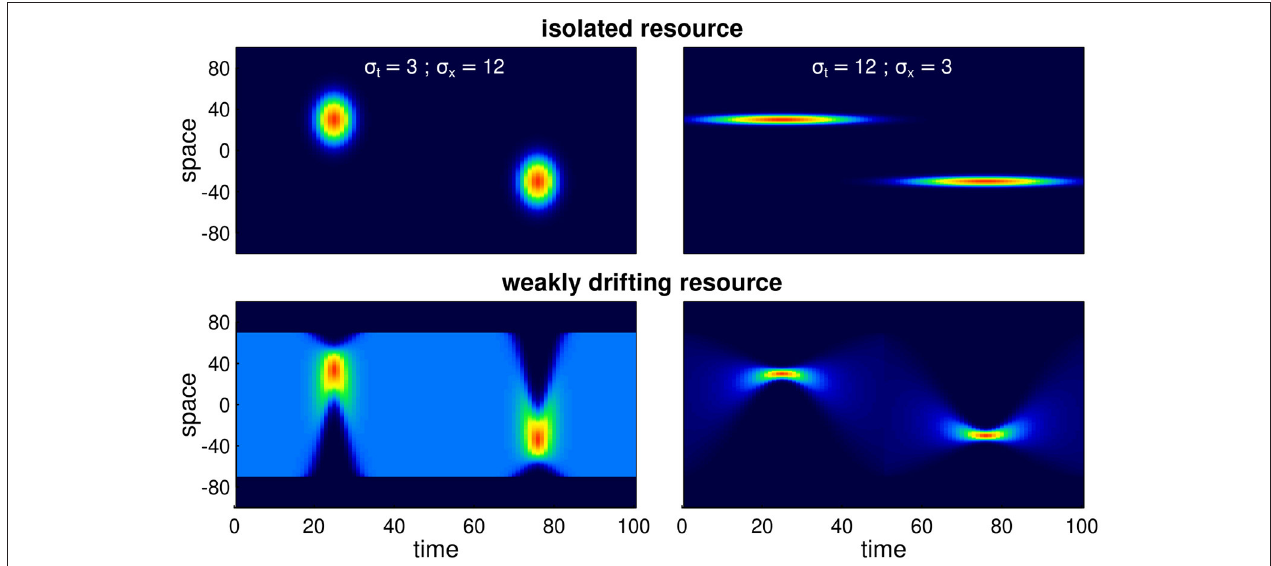
FIGURE 1 | Examples of various seasonal resource distribution functions, contrasting short duration, but wide pulses ( σ t spatially concentrated pulses ( σ t 12, σ x 3; right panels), and isolated resource pulses (upper panels) from the weakly drifting resource (lower panels). The total = = amount of resource is identical across all scenarios. In the weakly drifting resources, the total amount is constant at all times, and uniform in the middle of the phase (time = 0, 50, and